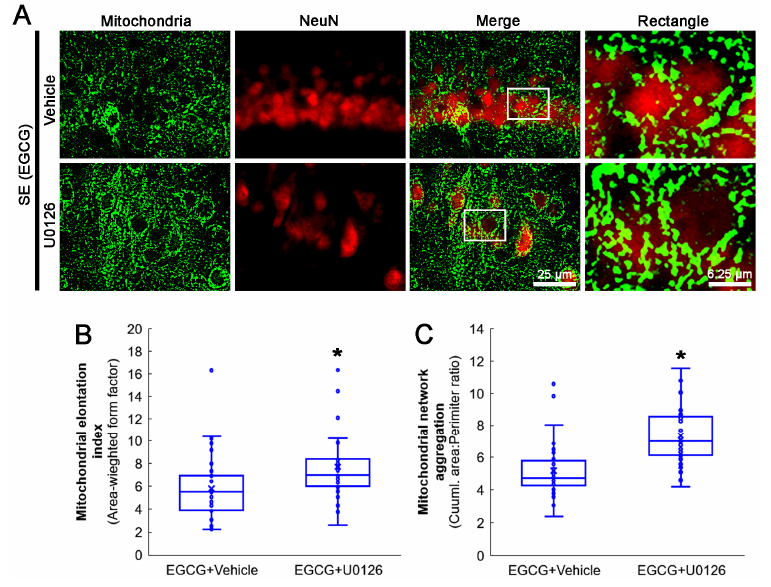
Figure 9. Effects of ERK1/2 inhibition by U0126 co-treatment on mitochondrial dynamics in CA1 neurons of EGCG-treated rats following SE. Compared with the vehicle, U0126 co-treatment